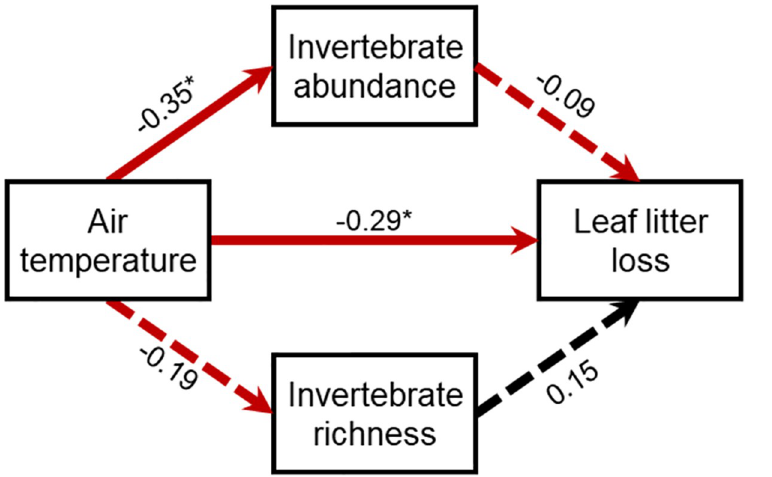
Fig 5. Structural equation model evaluating direct and indirect relationships between average air temperature in the warming chambers and invertebrate abundance, invertebrate richness, and leaf litter loss. The values reported are the standardized path coefficients. Solid lines indicate significant paths ( P < 0.05), while dashed lines indicate non- significant paths ( P > 0.05). Red lines indicate negative relationships while black lines indicate positive relationships. The R 2 for abundance = 0.11 and decomposition = 0.13. � P <